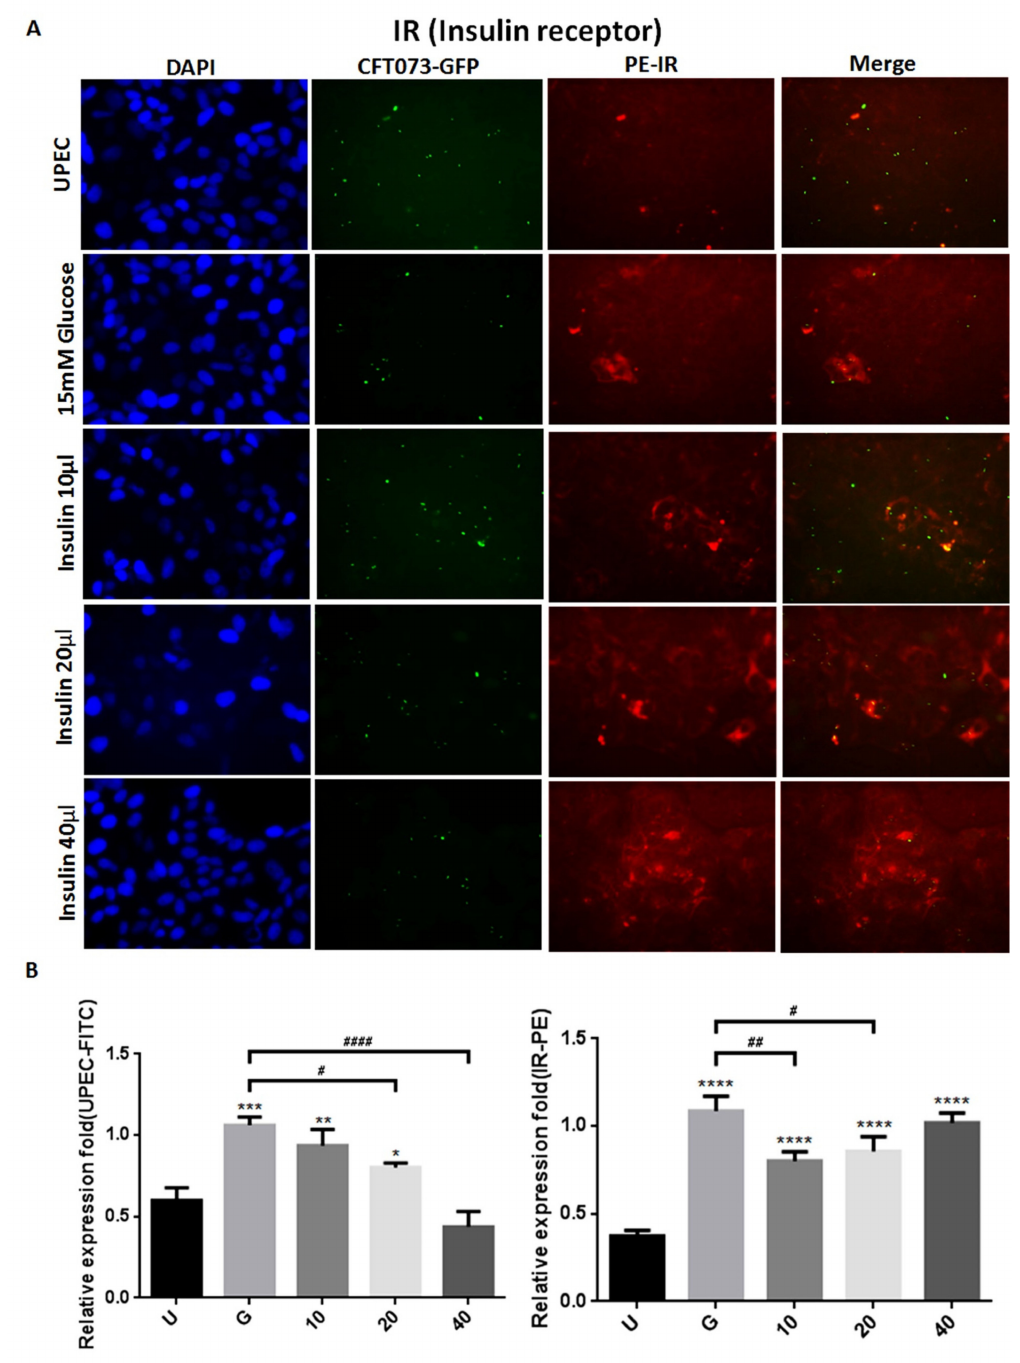
Figure 4. Insulin affected UPEC infection and insulin receptor expression in bladder cells. After 24 h of pretreatment with different concentrations of insulin and 15 mM glucose, GFP-UPEC and PE- insulin receptor (IR) expression in SV-HUC-1 cells post-infection were ( A ) observed by fluorescence microscopy and ( B ) measured using ImageJ software. Cells infected with UPEC alone were used as the positive controls. The data shown are representative of a typical result. DAPI was used to count the number of cells and as a standard for calculating the fluorescence expression ratio of cells. Cell images were captured using a microscope (Leica) at 100 × magnification. Data are expressed as mean ± SD from three separate experiments. The definitions of each letter/number represented by the X axis are: U: UPEC infection alone; G: with 15 mM glucose pretreatment; 10, 20 and 40: pretreated with 10, 20 and 40 µ g/mL insulin, respectively + 15 mM glucose. * p < 0.05; ** p < 0.01, *** p < 0.001, **** p < 0.0001, compared to positive control groups. # p < 0.05, ## p < 0.01, #### p < 0.0001, compared between the two